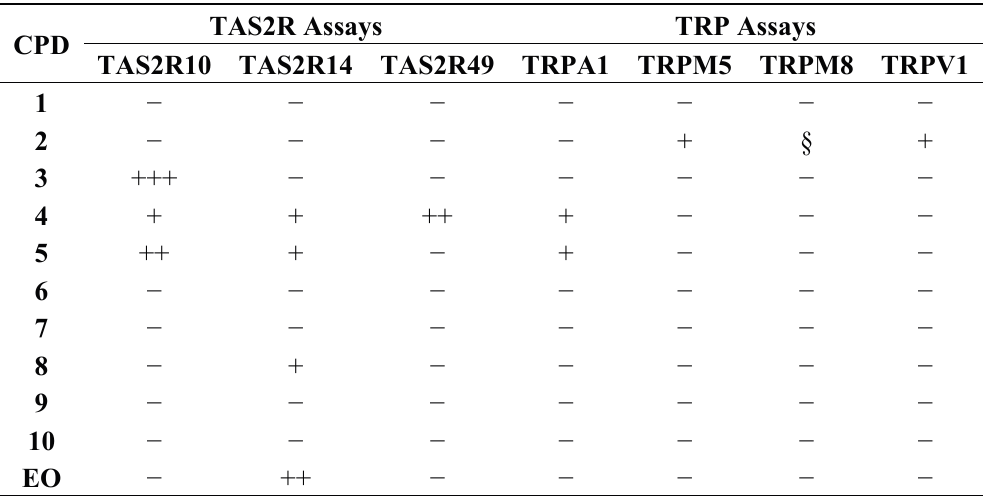
Table 1. In vitro assays of isolated phytochemicals and essential oil from rue. TAS2R Assays TRP Assays CPD TAS2R10